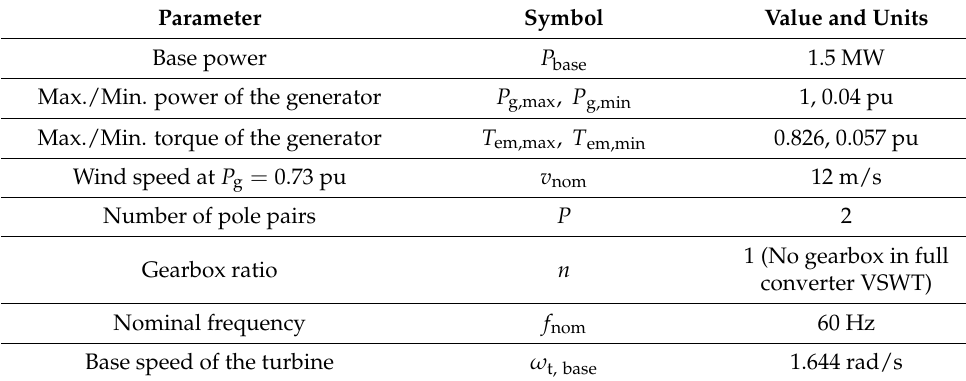
Table A1. Wind turbine